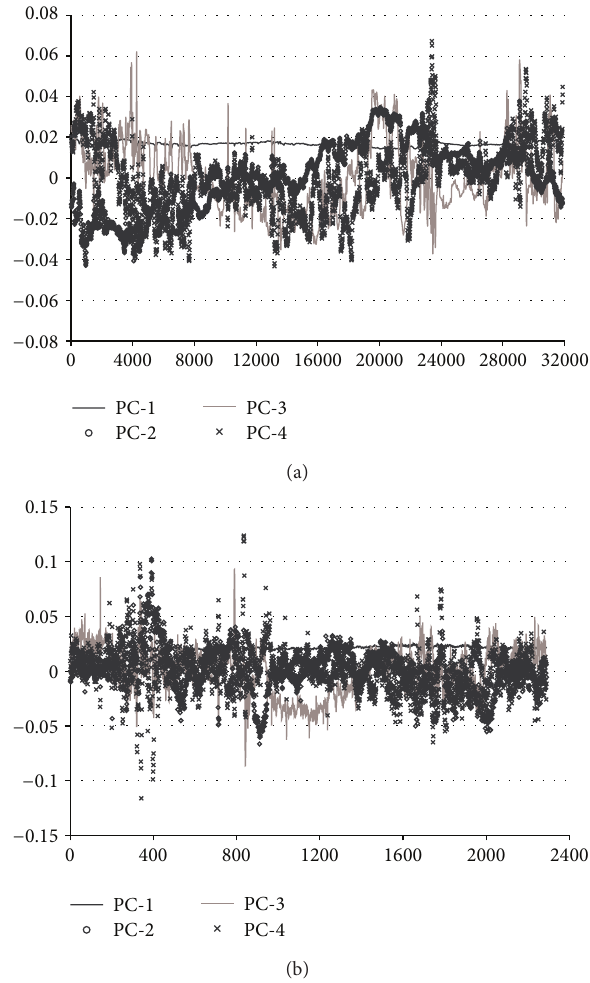
Figure 6: Four first principal components of PCA calculations for all thermal fingerprints of French (a) and UK (b)